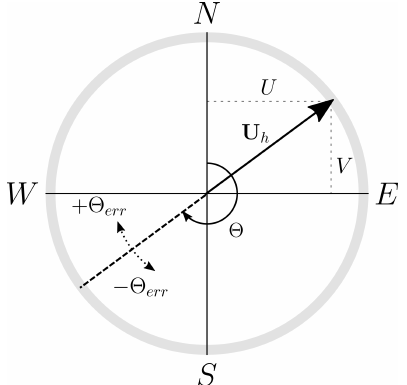
Figure 5. Conventions used for the horizontal wind vector direction and signs of the wind direction